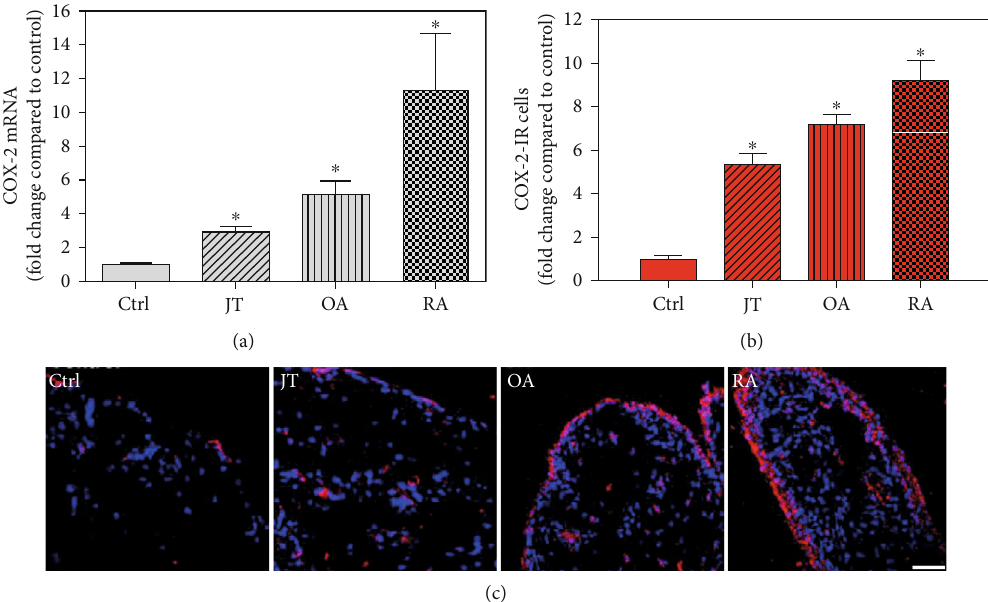
Figure 3: Detection of cyclooxygenase 2 (COX2) mRNA (a) and the number of COX-IR cells (b, c) in patients with joint trauma (JT), osteoarthritis (OA), and rheumatoid arthritis (RA). Quanti fi cation of COX-2 mRNA (a) and immuno fl uorescence positive cells (b) shows that COX-2 expression was more prominent in JT, OR, and RA compared to synovium of controls (data are shown as means ± SEM , P < 0 : 05 , one-way ANOVA followed by Tukey ’ s test). (c) Immuno fl uorescence microscopy for COX-2 (Texas red fl uorescence) shows more abundant COX-2-IR cells in JT, OR, and RA compared to control synovium. SEM. DAPI blue fl uorescence shows nuclear staining. Bar = 20 μ m . ( ∗ P < 0 : 05 , compared to control).